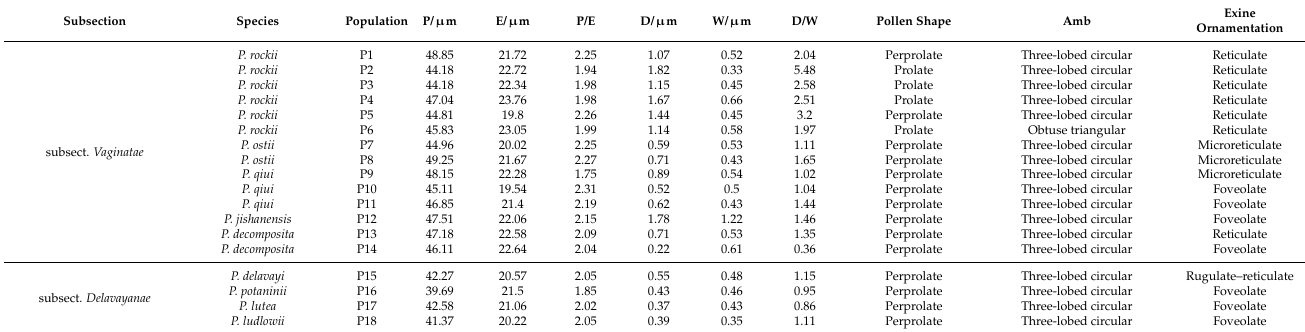
Table 3. Pollen micromorphological features of the examined population.